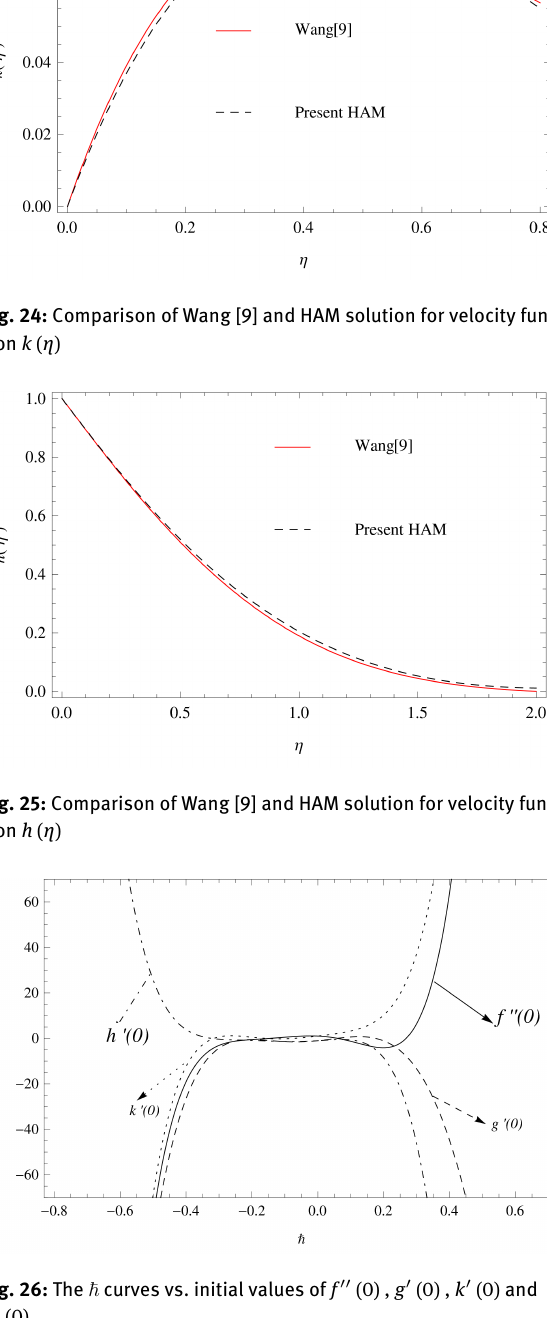
Fig. 26: The (cid:126) curves vs. initial values of f (cid:48)(cid:48) (0) , g (cid:48) (0) , k (cid:48) (0) and h (cid:48)